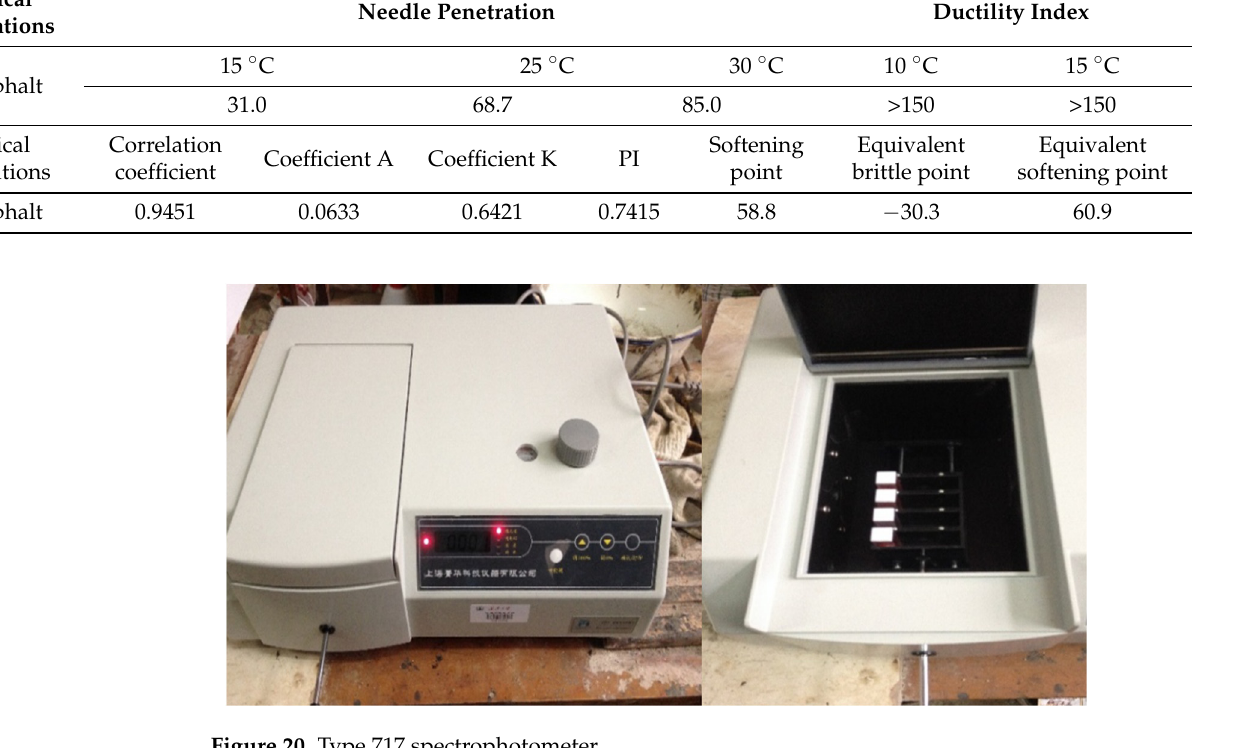
Table 5. Technical properties of 70# matrix asphalt.